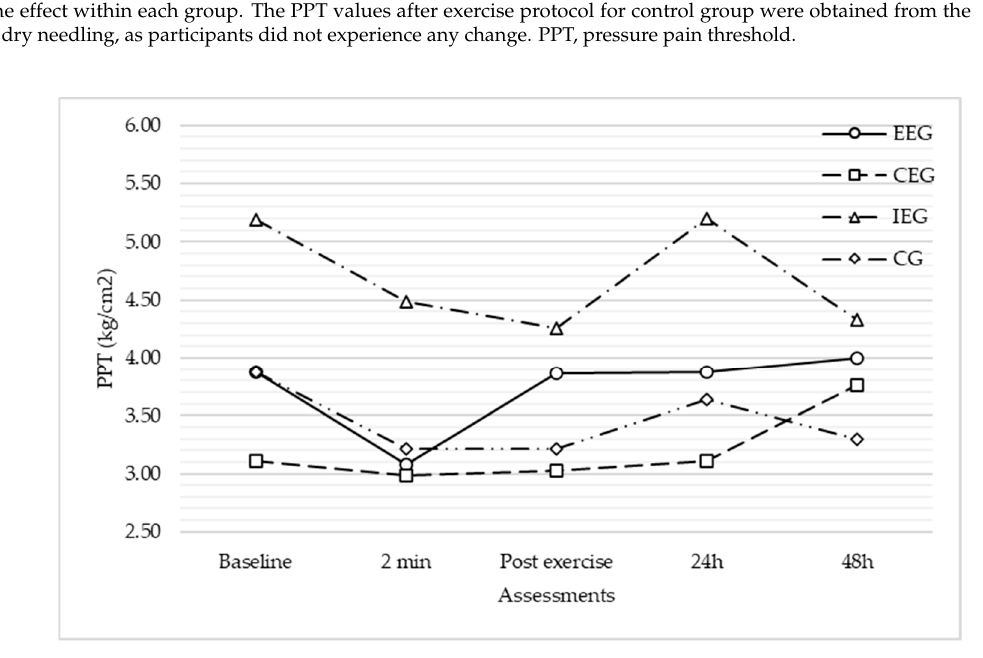
Figure 3. Comparison analysis of the change in the pressure pain threshold over time between groups. No differences between groups within each assessment ( p > 0.05). p- values proceeding from multiple pairwise comparisons per time*group, adjusting for group (mixed ANOVA); comparisons between groups in each assessment (based on estimated marginal means). EEG, eccentric exercise group; CEG, concentric exercise group; IEG, isometric exercise group; CG, control group; PPT, pressure pain threshold.